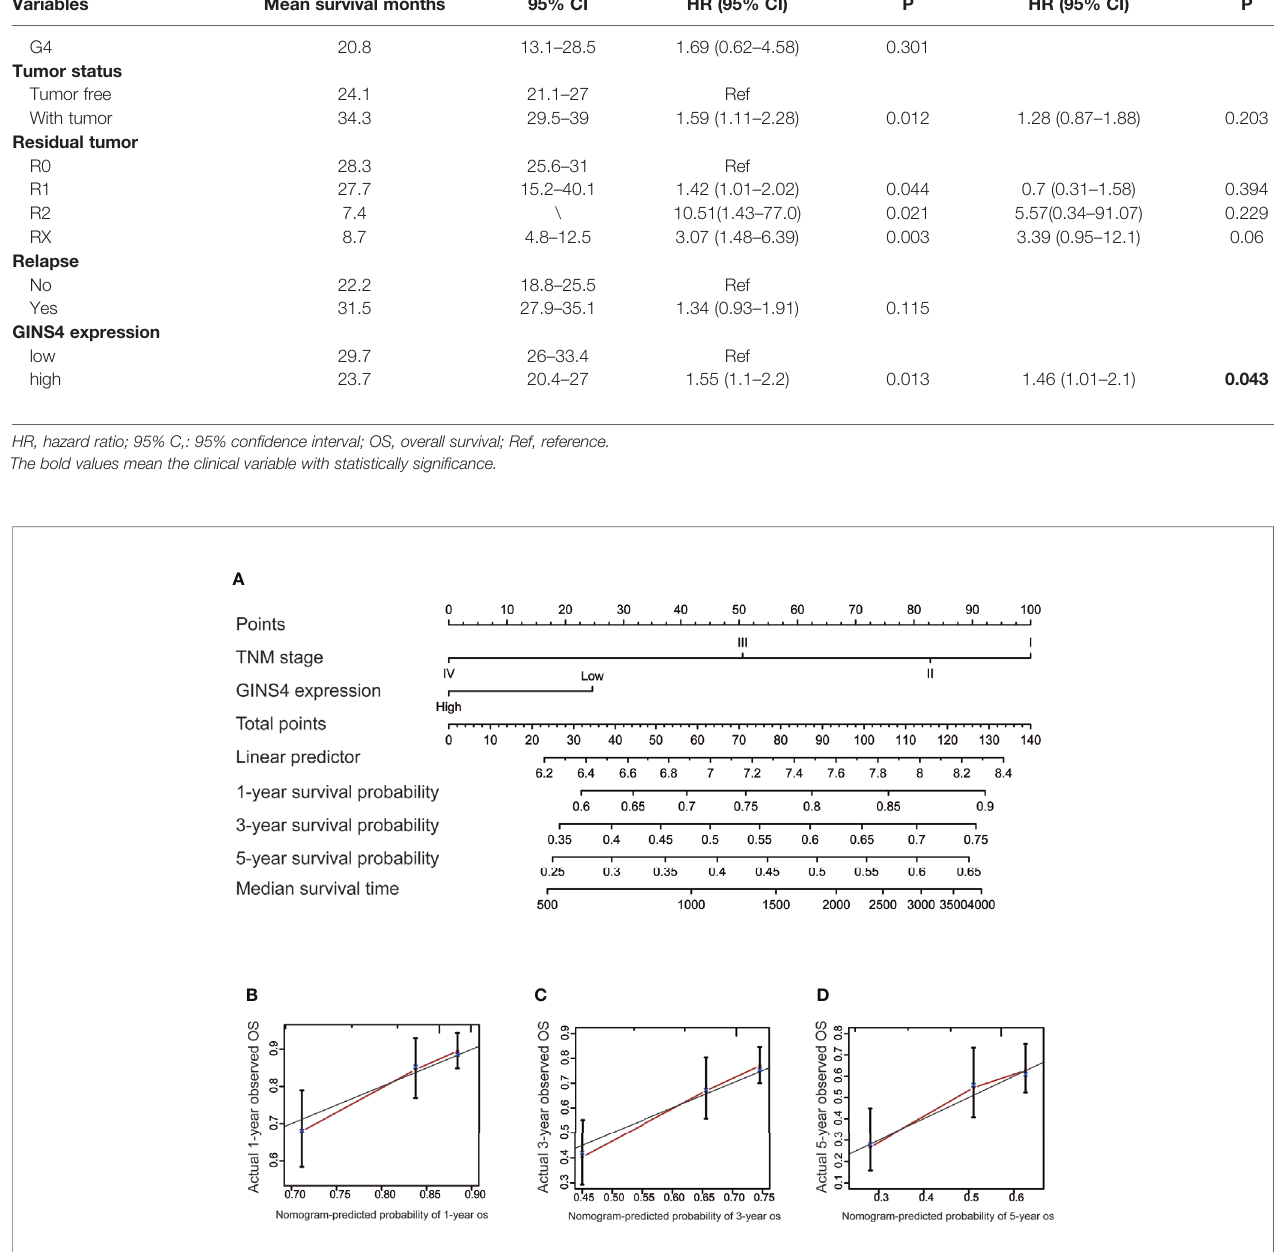
FIGURE 9 | Nomogram to predict the long-term OS of 371 HCC patients from the TCGA database. (A) Nomogram model including TNM stage and GINS4 expression level to predict the 1-, 3-, and 5-year OS of HCC patients. The calibration plots of (B) 1-year, (C) 3-year, and (D) 5 year-OS of HCC patients. OS, overall